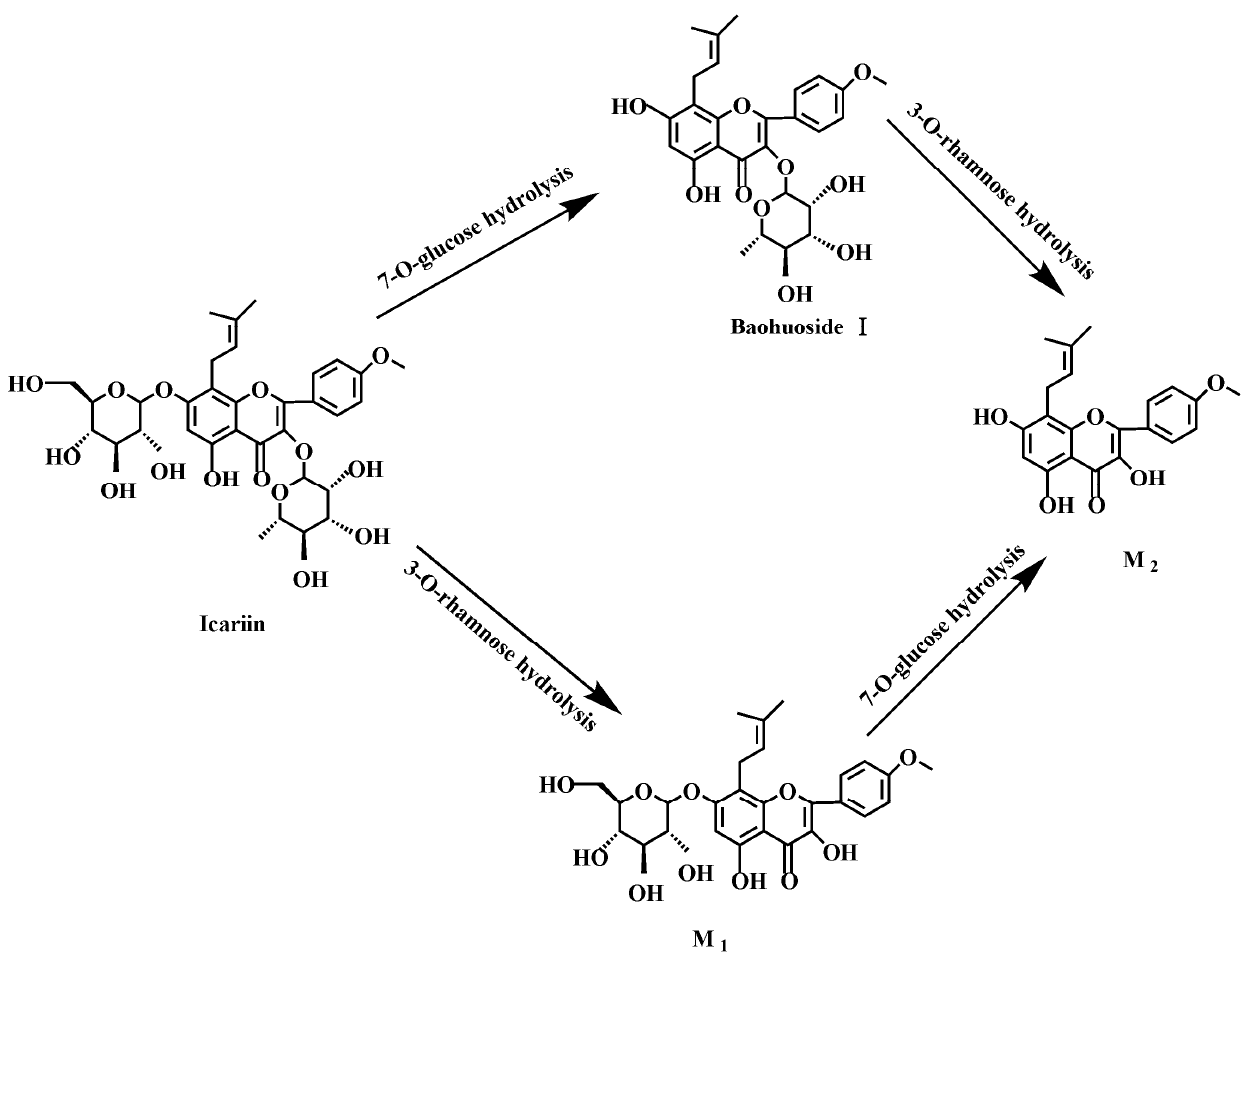
Figure 11. The metabolic pathway of icariin in intestinal flora and enzyme of